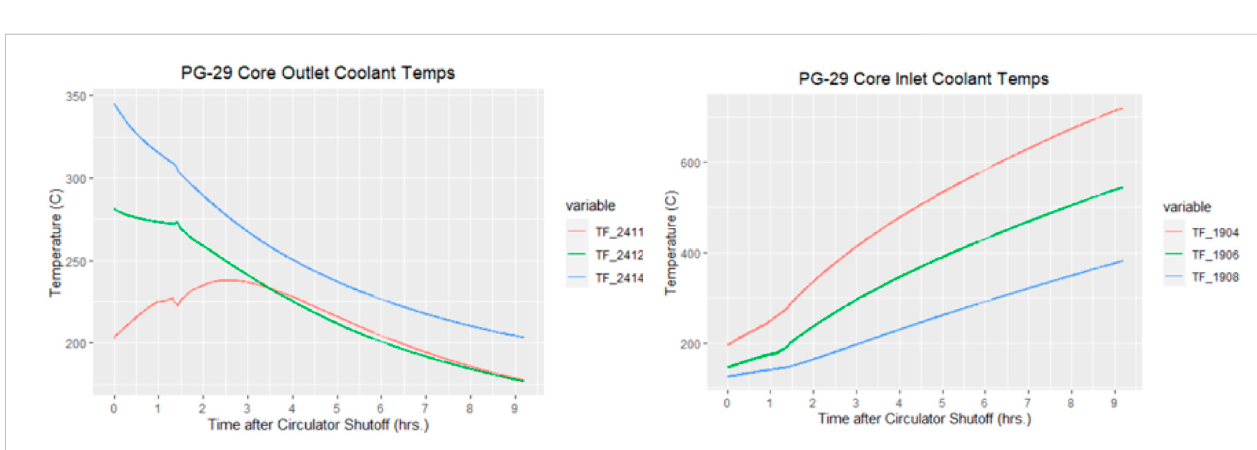
FIGURE 4 PG-29 core outlet (left) and inlet (right) coolant temperatures.